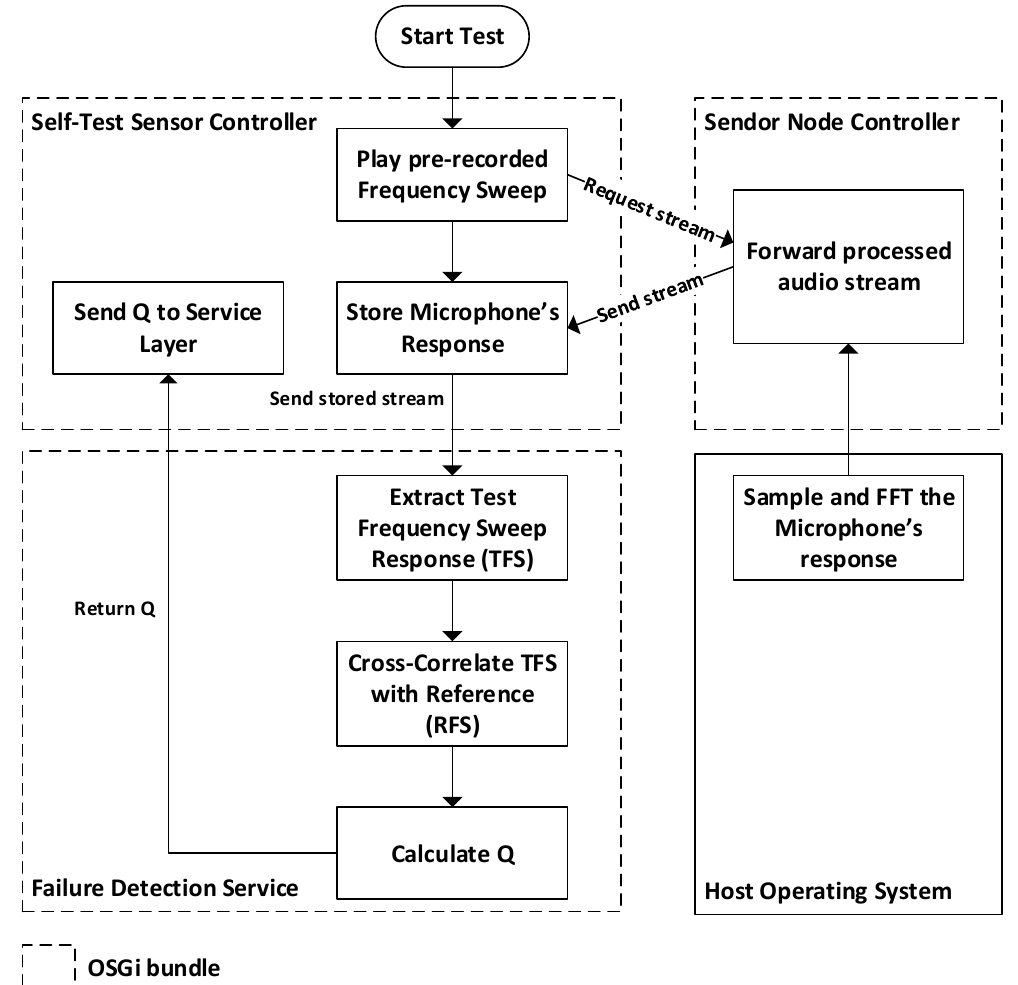
Figure 6. This flow diagram describes the complete process—lasting around 16 s—of a self-test. Test triggering and reporting is performed in the Self-Test Sensor Controller bundle while sensor quality quantification is performed in the Failure Detection Service